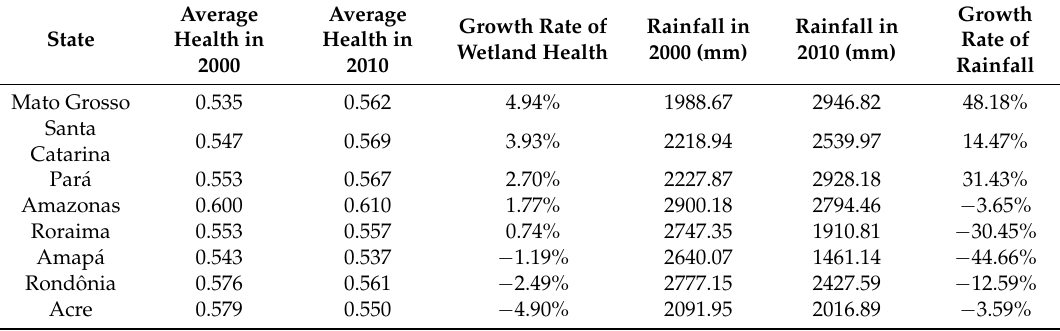
Table 7. The average health of wetland ecosystem and rainfall in different Amazon River Basin states. Average State Health in Mato Grosso Par á Amap